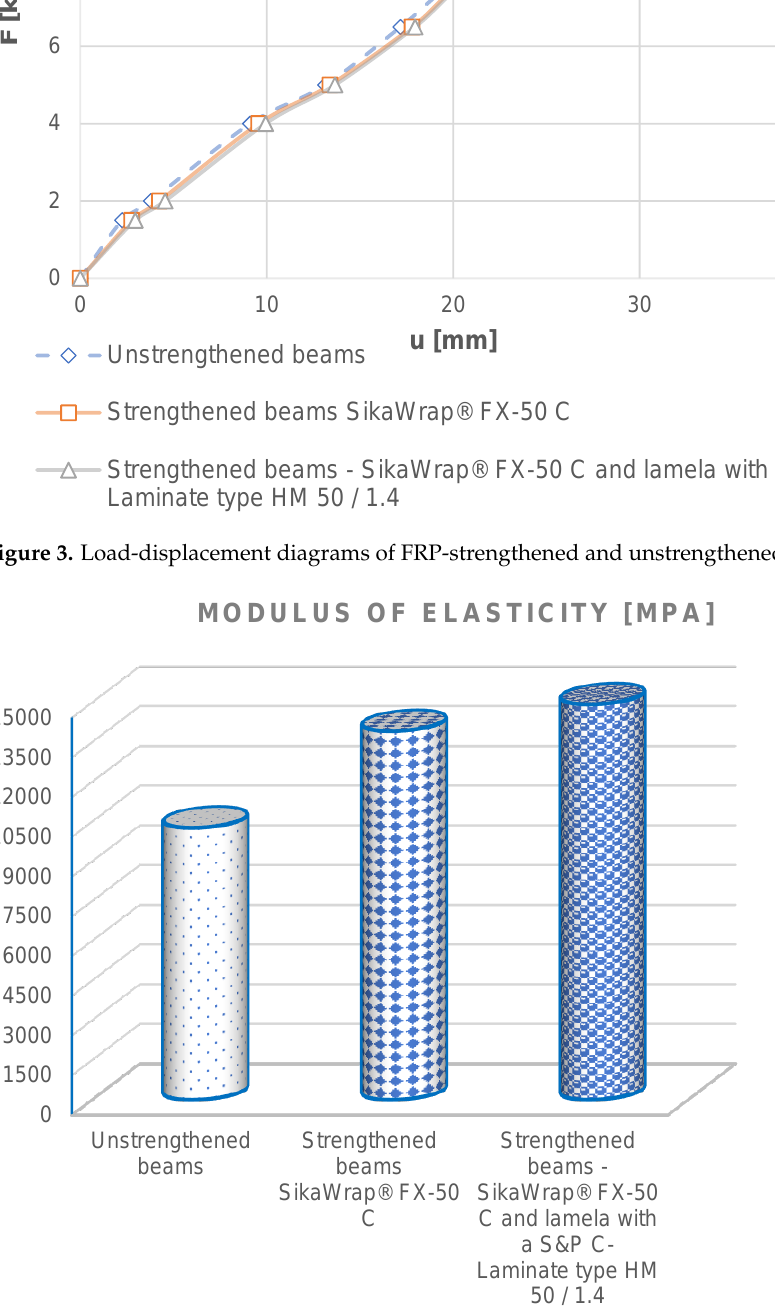
Figure 4. Diagrams of the moduli of elasticity of strengthened and unstrengthened beams.